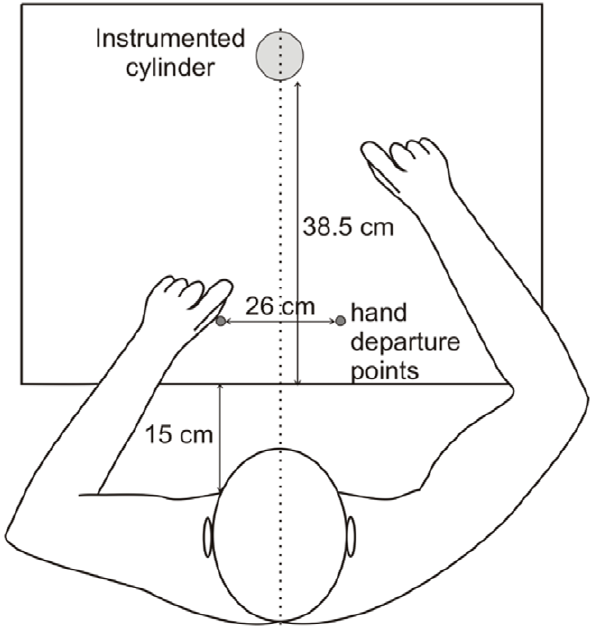
Figure 1. The experimental paradigm. Participants wore head- phones and were seated on a chair facing a table. The instrumented cylinder was placed at a distance of 53.5 cm from their chest.